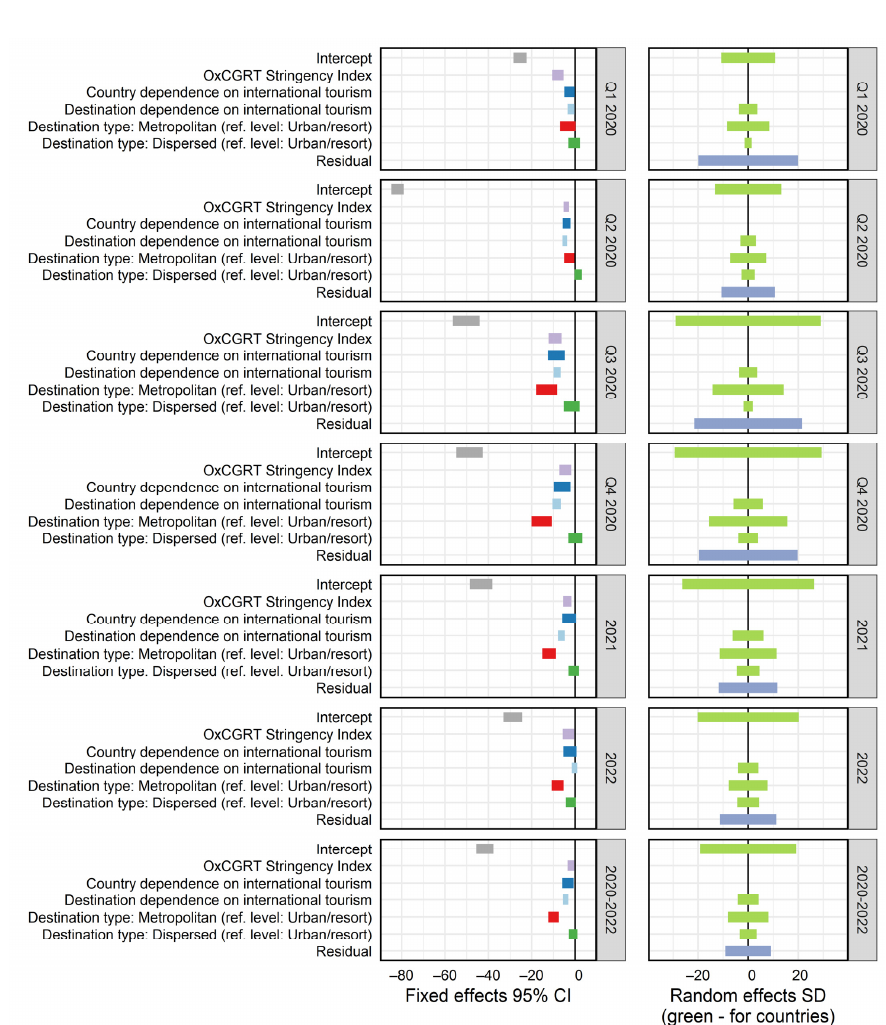
Figure 6. Linear mixed-effects model explaining the decrease in the number of reviews in destinations compared to 2019.